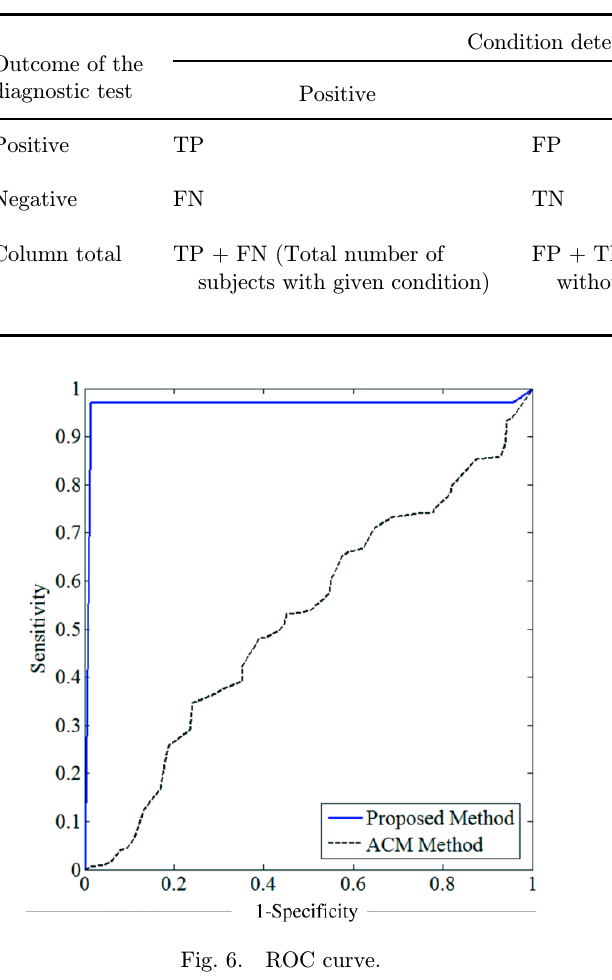
Table 1. Terms used to de¯ne sensitivity, speci¯city and accuracy.